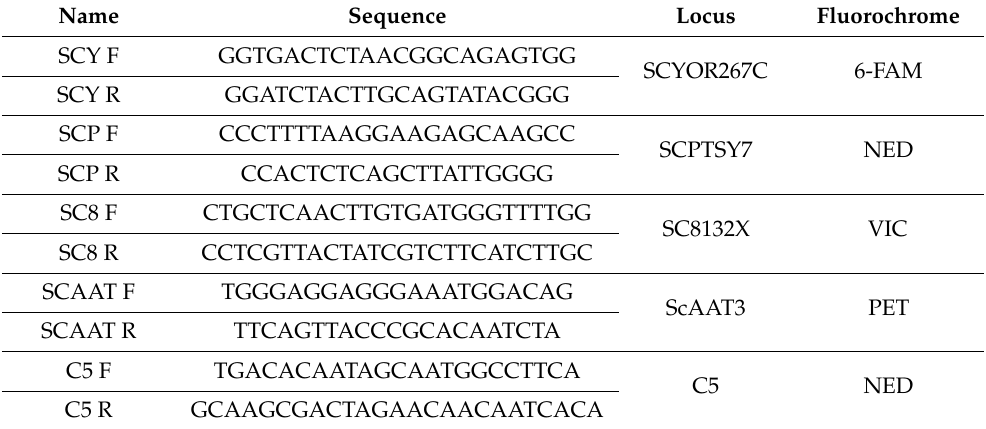
Table 3. Microsatellite PCR